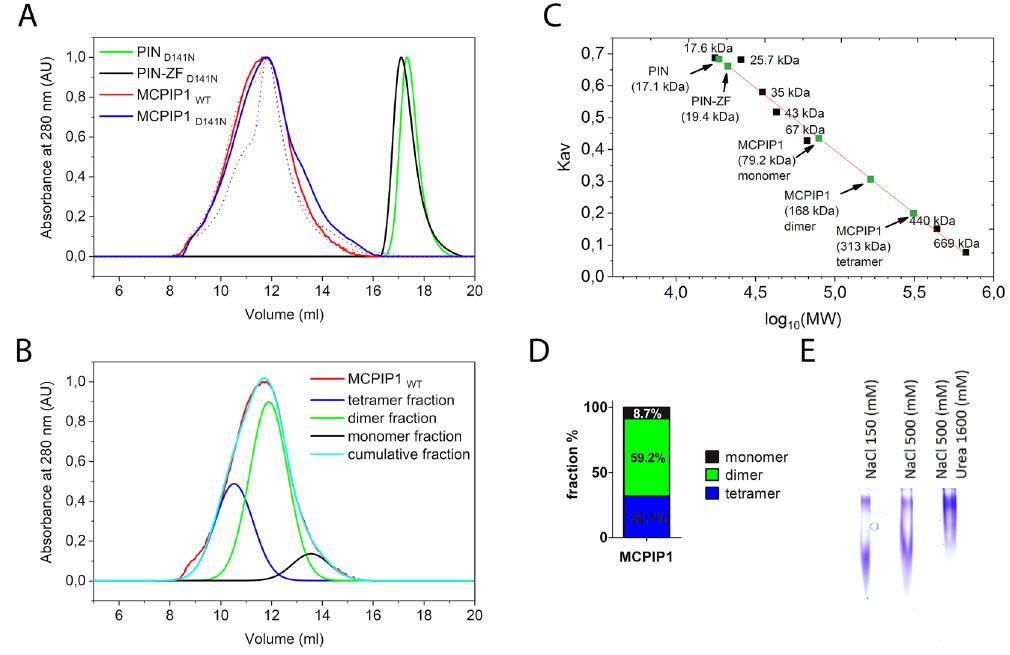
Figure 5. Homooligomerization of the MCPIP1 protein. ( A ) Size exclusion chromatography results of MCPIP1. Chromatography was performed in a buffer comprised of 25 mM Tris, pH 7.9, 300 mM NaCl, 10% (w/v) glycerol, 1 mM DTT, and 0.5 mM EDTA. Additionally, for results shown as a dotted line, the buffer was enriched in 1.6 M urea. ( B ) A multiple Gaussian peak fit was performed to model the obtained elution